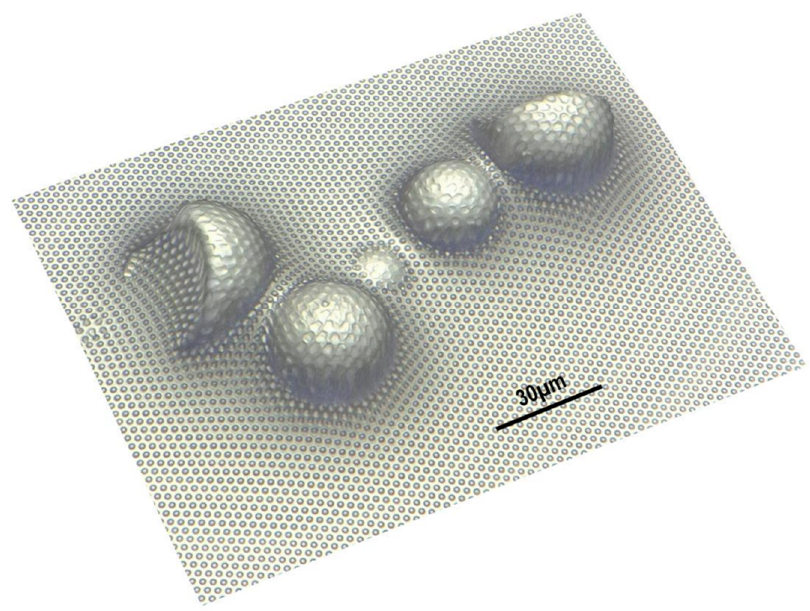
Figure 13. Optical micrograph (3D image stacking using a Keyence VHX-5000 digital microscope) of different types of microspheres over-imprinted with a PDMS stamp. In contrast to Figures 11 and 12 here, the stamp contained pillars instead of holes. It can clearly be seen that the pillars on the stamp are less stable under the imprinting pressure and collapse on top of the spheres, whereas the holes in the stamp remain more stable as can be seen in Figure 12.